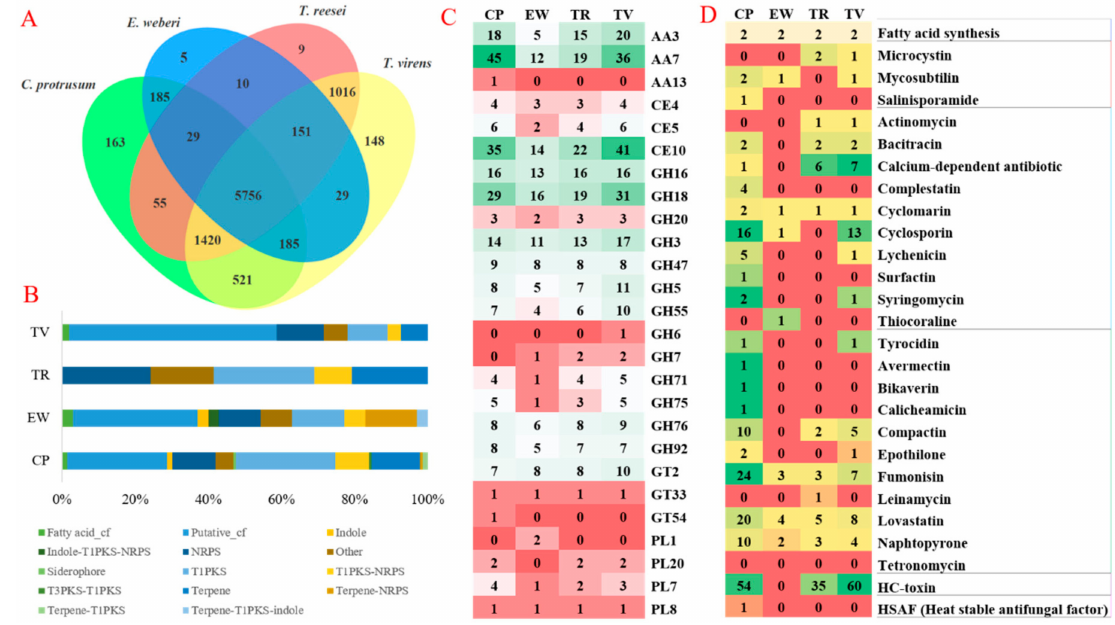
Figure 2. Comparative genomic analysis, carbohydrate-active enzymes (CAZymes) and secondary metabolites (SMs) of C. protrusum and three other fungi in the Hypocreaceae family. ( A ) Comparison of the protein-coding genes of C. protrusum with those of other Hypocreaceae with different lifestyle E. weberi (27.20 Mb, 6870 genes), TR (33.39Mb, 9115 genes) and TV (39.02Mb, 12,406 genes) based on orthology analysis. ( B ) The number of antiSMASH SMs of C. protrusum and EW, T. reesei (TR), and T . virens (TV). ( C ) Abundance of CAZyme modules in C. protrusum and EW, TR, and TV. ( D ) The number of NaPDoS SMs of C. protrusum and EW, TR, and